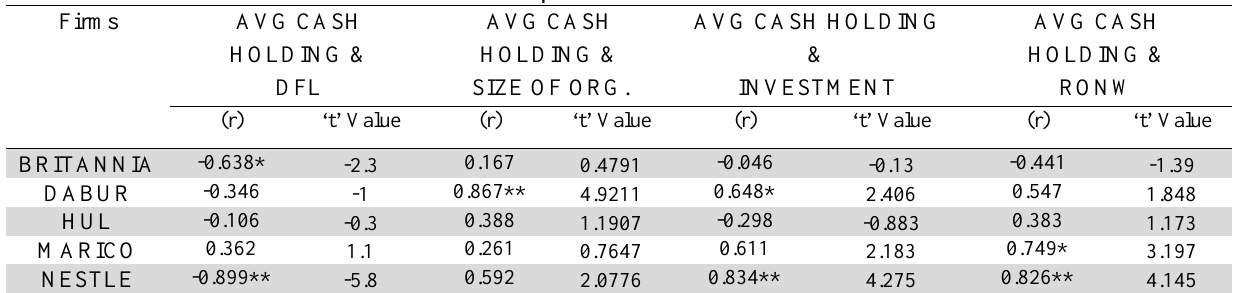
Karl Pearson’s Simple Correlation Analysis between AVG Cash Holding and DFL, Size of Org., Investment and RONW of the Selected Companies from FMCG